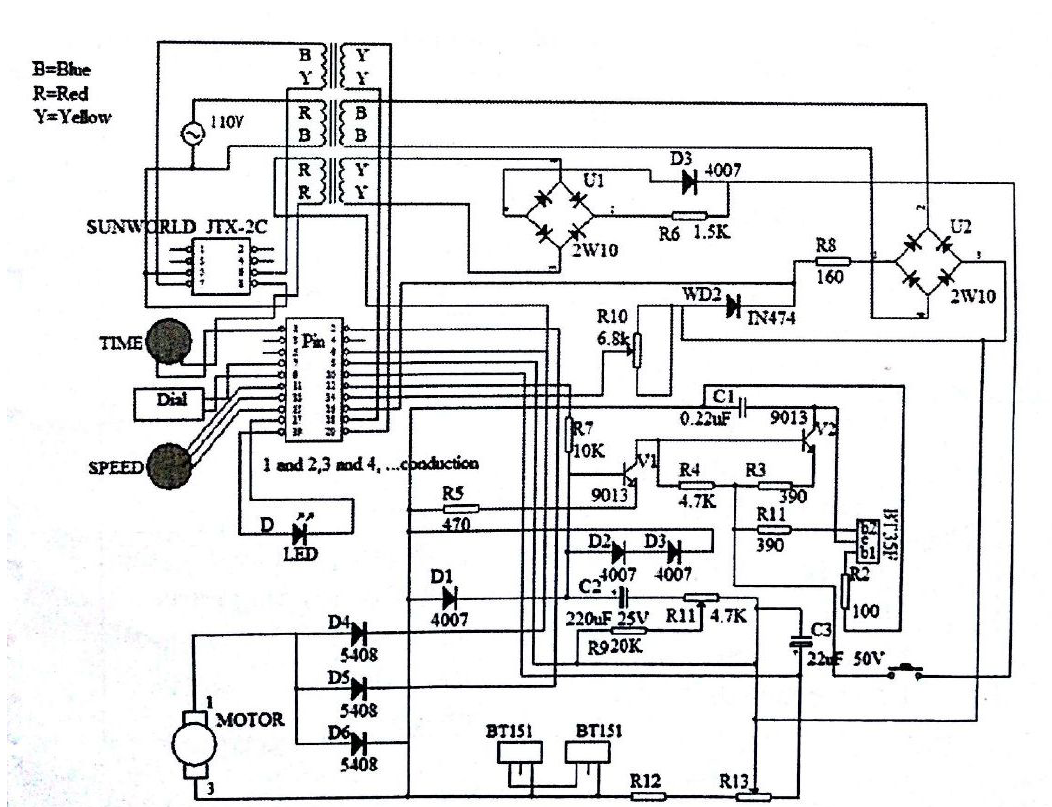
Figure 3. The electrical circuit diagram of rotation speed controller.